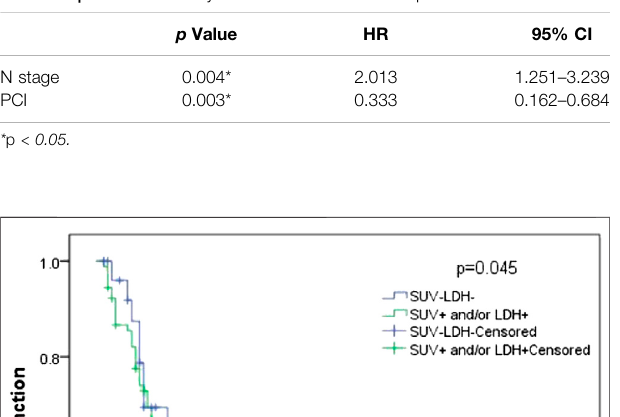
TABLE 7 | Multivariate analysis of overall survival in 64 patients with ED SCLC.